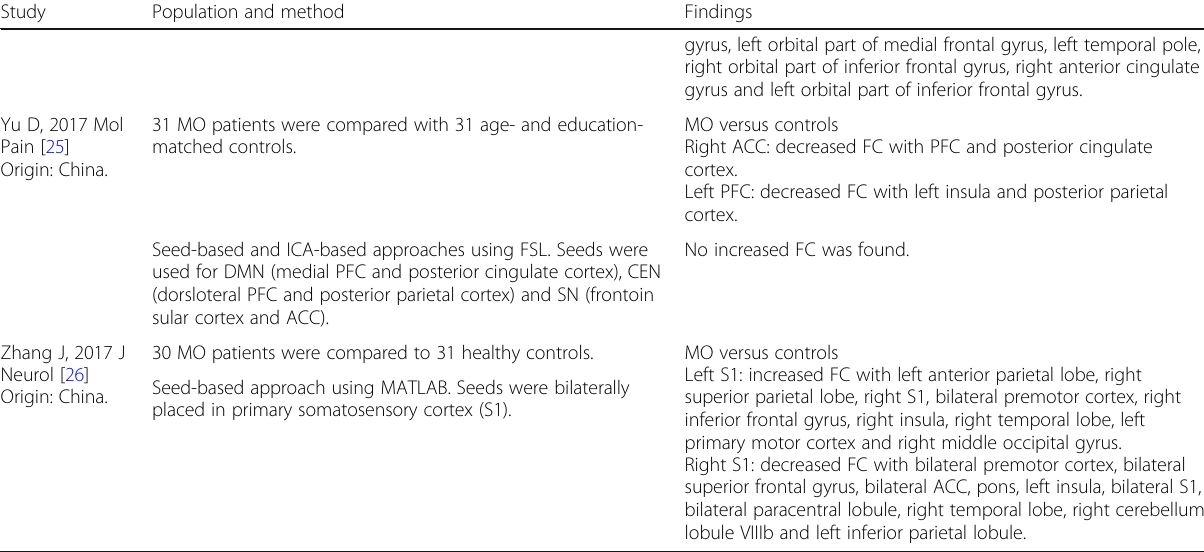
Table 1 Functional connectivity MRI during the interictal phase of migraine compared with non-migraine controls (Continued) Study Population and method Findings